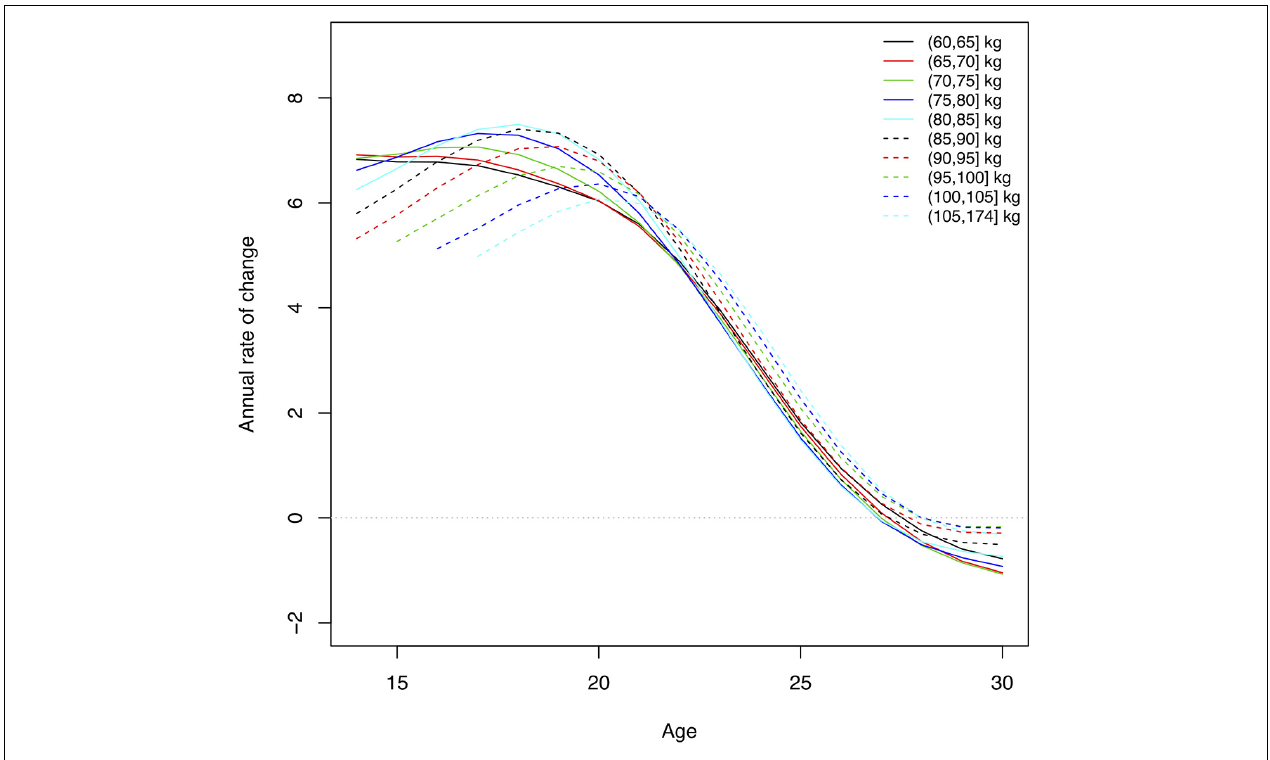
FIGURE 5 | Annual rate of change in performance levels, at the 90th percentile, by age and body mass for men. Lines represent the rate of change in total weight lifted for athletes with different body mass. This corresponds to the derivative of the curves for performance levels, where zero indicates the age at which there was a maximum in the absolute performance